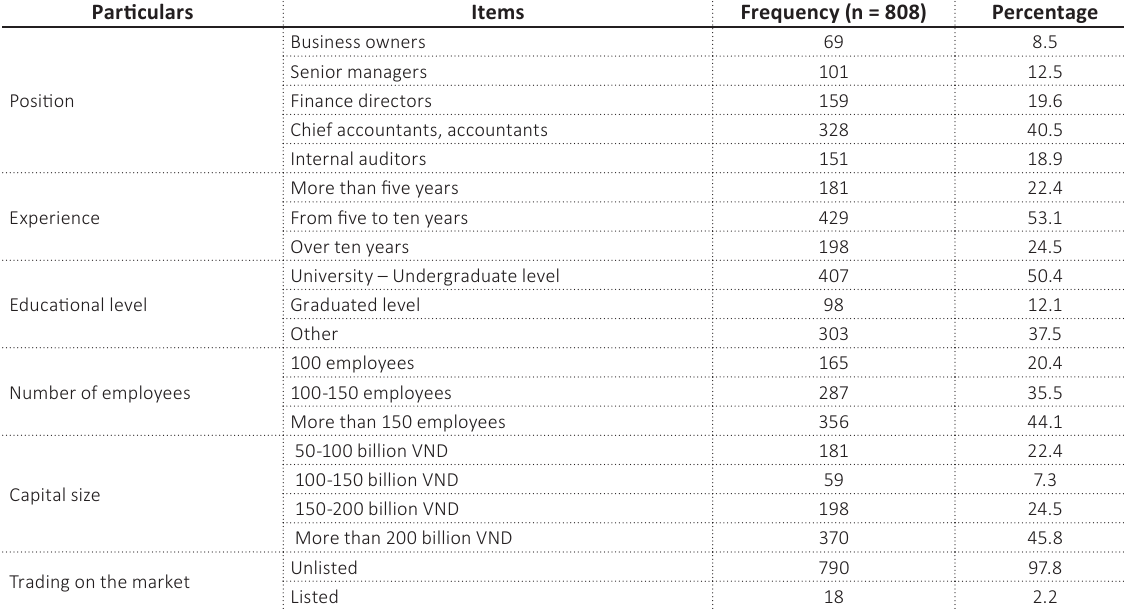
Table 1. Demographic characteristics of